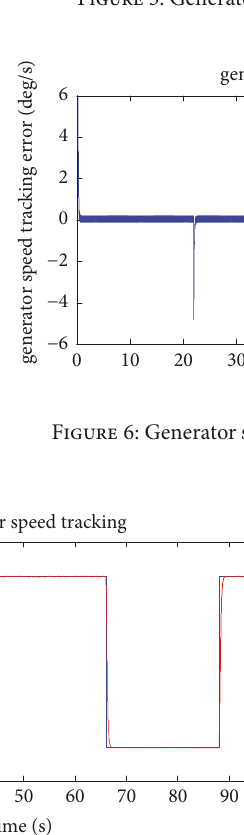
Figure 5: Generator speed tracking with general VSC.